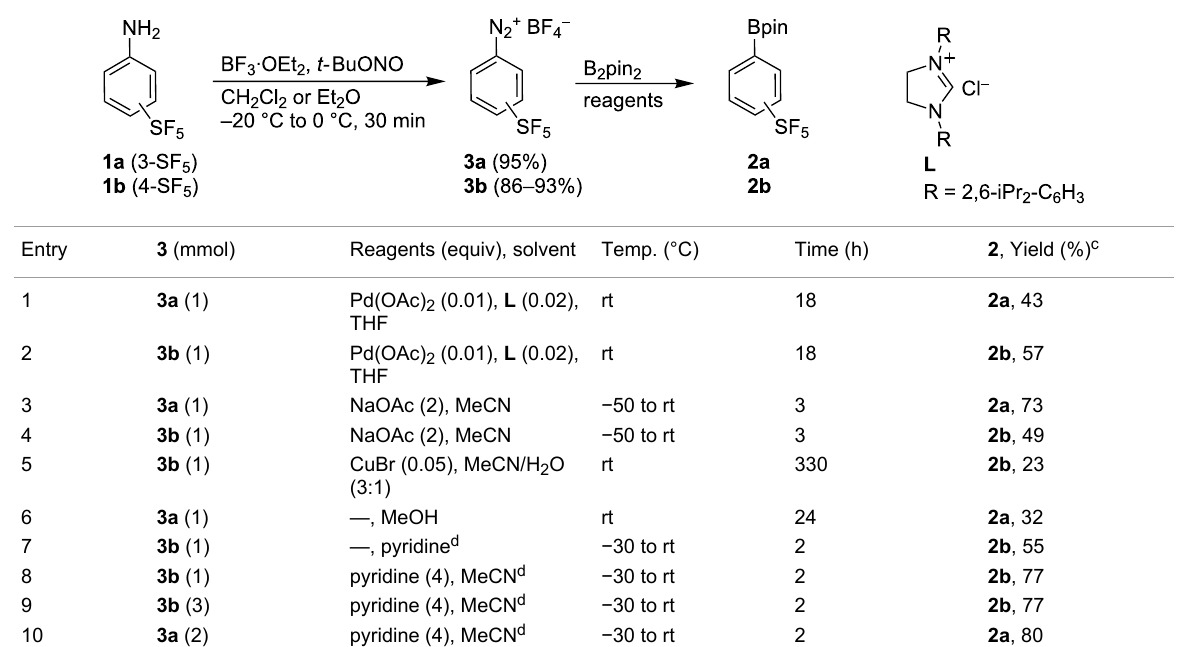
figuration) and 6i in 16:31:28:25 GC–MS ratio. The presence of these products can be explained only by the formation of the substituted SF 5 -phenyl radical which undergoes borylation to 2i , hydrogen atom transfer followed by borylation to 2i’ , intramolecular cyclization to 5 i or hydrogen abstraction to 6i